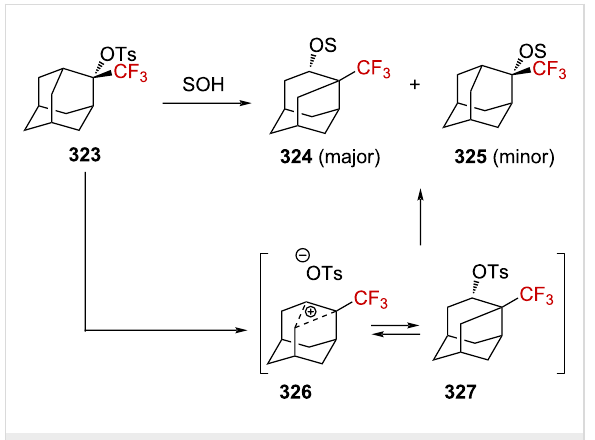
Scheme 79: Mechanism for the solvolysis of 323 . SOH =